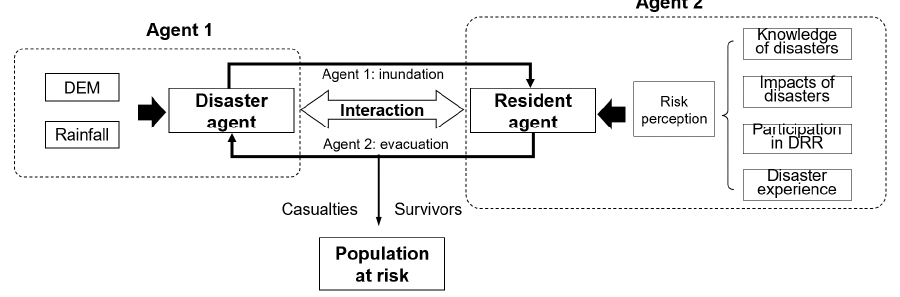
Figure 3. Interactions of agents in the ABM model.